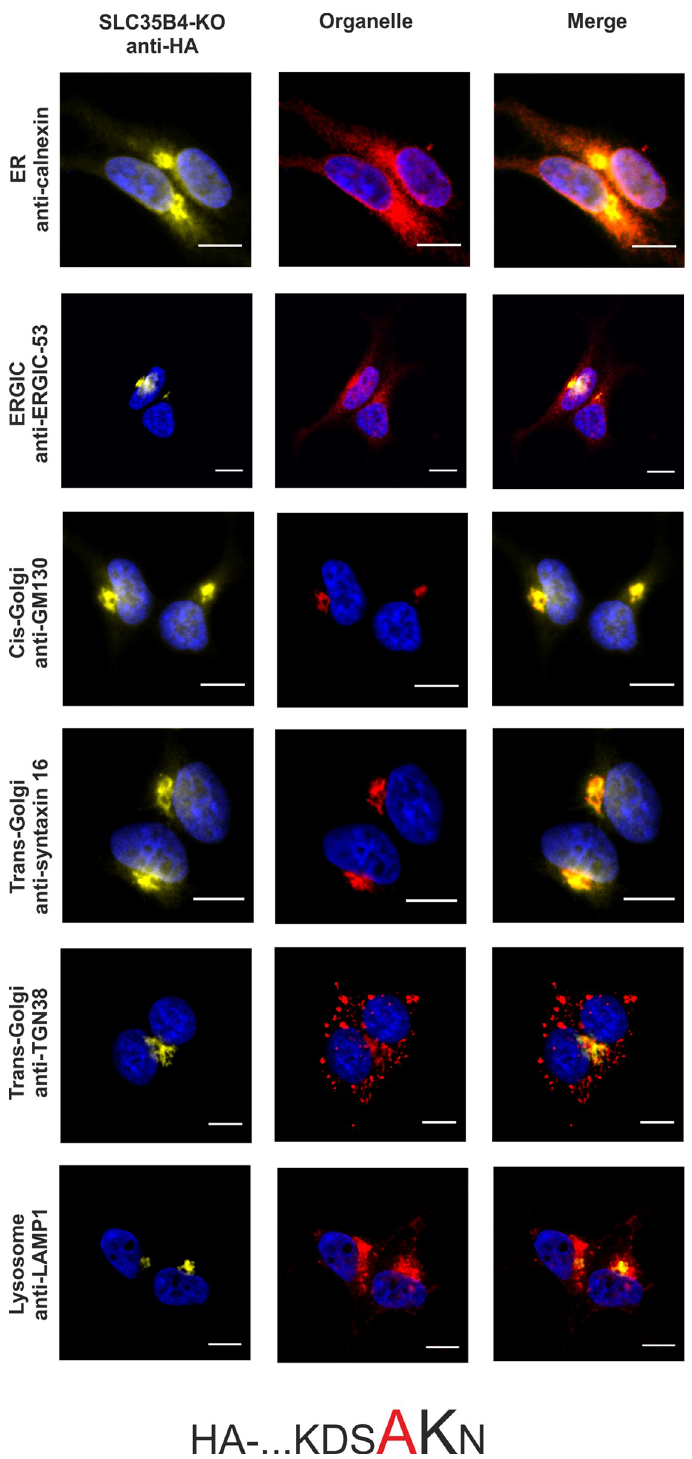
Fig 10. Subcellular localization of HA- ... KDSAKN, human SLC35B4 K329A with HA-epitope at the N-terminus in the knock-out HepG2 cells. Stably transfected cells, lacking functional SLC35B4 gene (SLC35B4-KO), overexpressing SLC35B4 variants, were subjected to indirect immunofluorescent staining with anti-HA (green) and anti-organelle markers (Table 3) (red) antibodies. Cell nuclei were counterstained with DAPI. Scale bar 10 μ m.